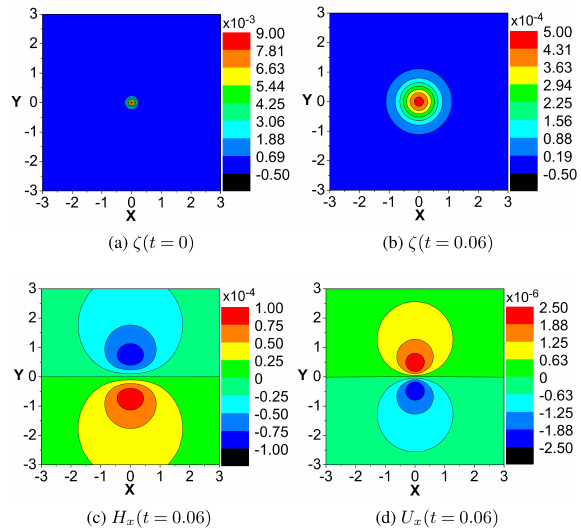
Fig. 6. The spatial distributions of normalised ζ , H x and U x compo- Fig. 6: The spatial distributions of normalised ζ , H x and U x components of magnetic field and velocity are taken at hight nents of magnetic field and velocity are taken at hight Z = 600km Z = 600 km (night time). PEMW was excited by vertical component of magnetic vortex ζ z ( ζ ( t = 0) max = 0 . 01) . The scaling (night-time). PEMW was excited by vertical component of mag- of X , Y and normalised value of H x is the same as in Figs. 3. The velocity component U x is normalised by V A = 46 km/s. netic vortex ζ z ( ζ(t = 0 ) max = 0 . 01 ) . The scaling of X , Y and nor- malised value of H x is the same as in Fig. 3. The velocity compo- nent U x is normalised by V A = 46kms − 1